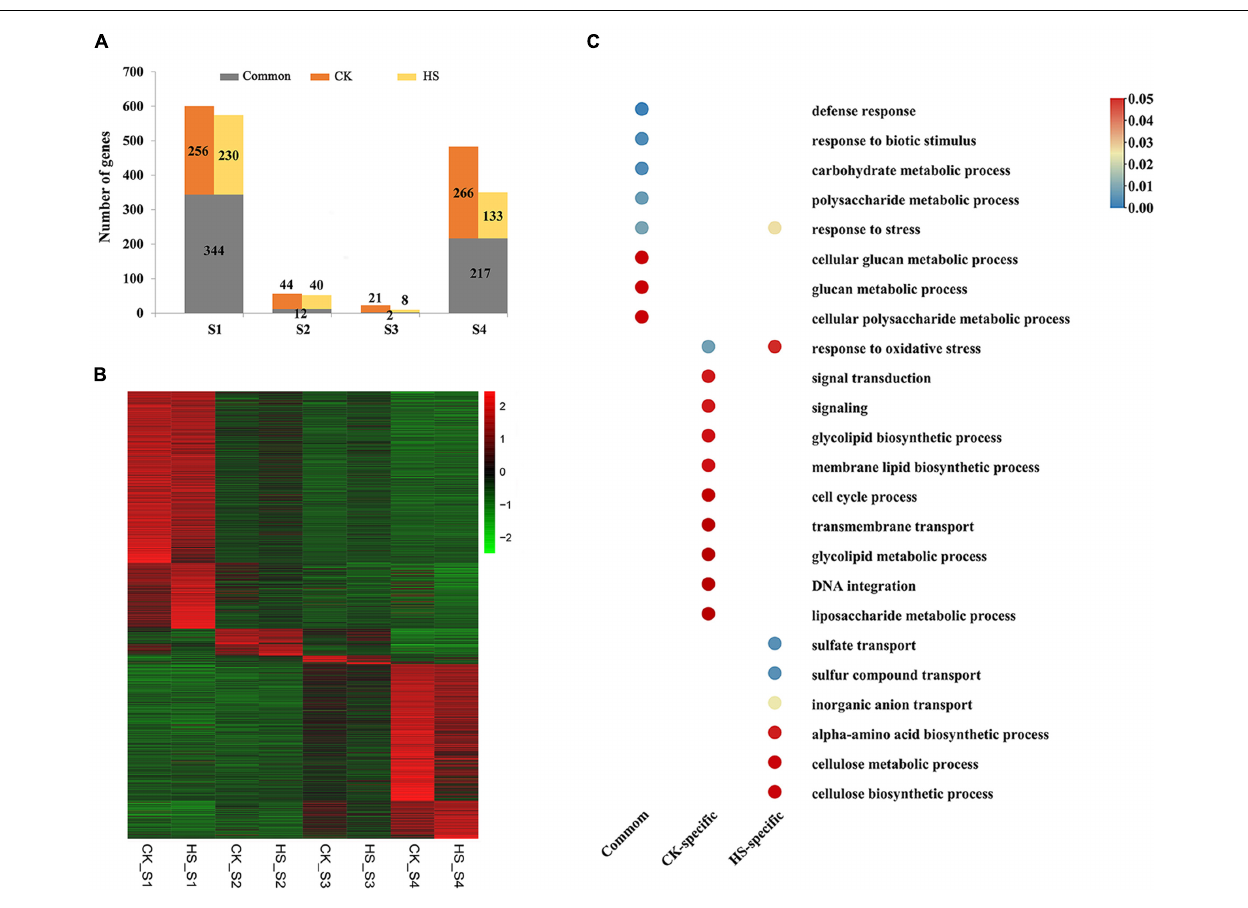
FIGURE 3 | Specifically expressed genes at male development stages in cucumber. (A) The number of specifically expressed genes specifically and commonly in CK and HS at each stage of anther development. (B) The expression profile of specifically expressed genes between in CK and HS. Color scale represents Z-score. (C) The significantly enriched gene ontology (GO) terms (biological process) of specifically expressed genes at anther development in CK and